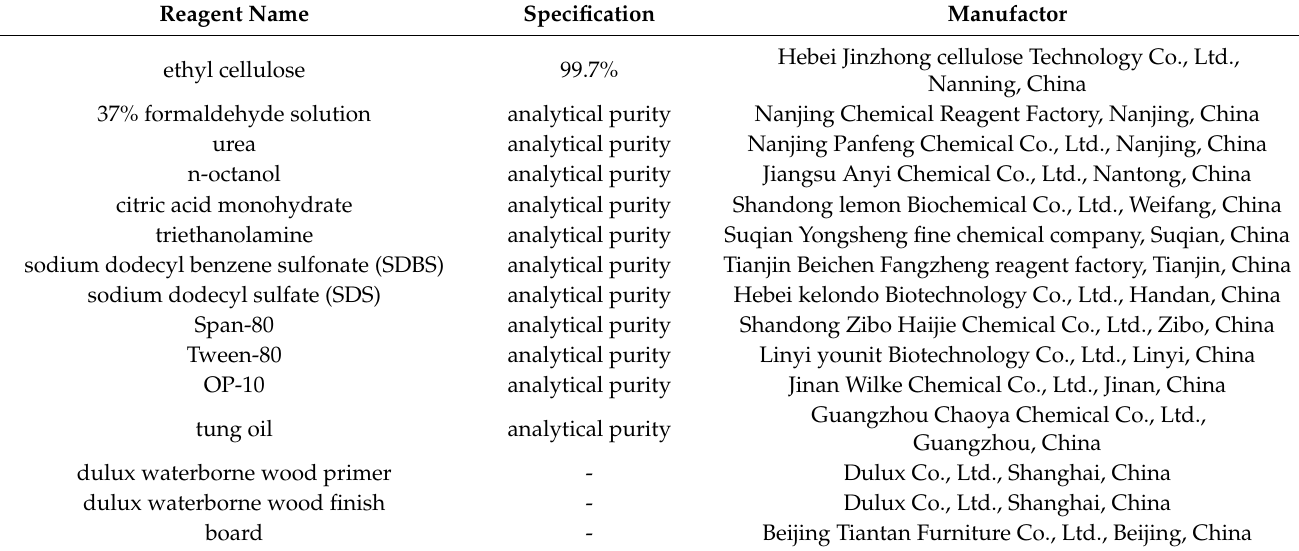
Table 1. List of experimental materials.